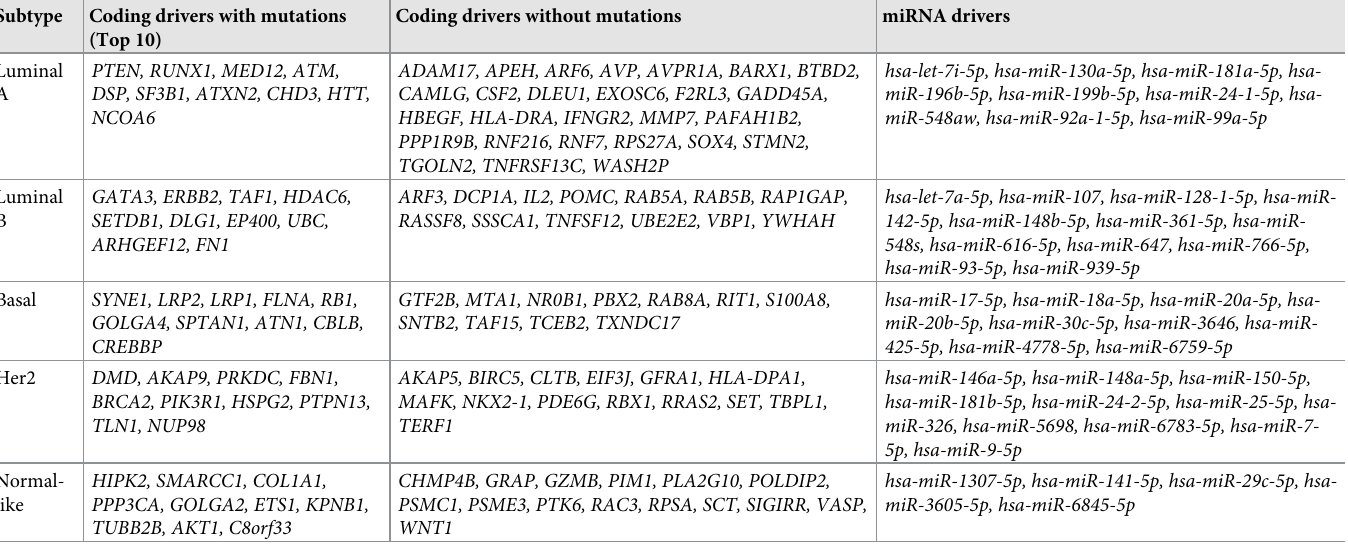
Table 3. Predicted drivers which are specific to each breast cancer